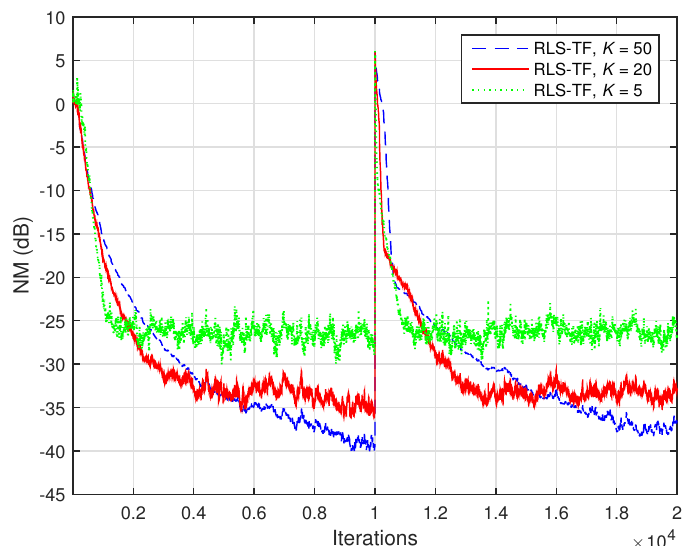
Figure 4. Normalized misalignment (NM) evaluated based on (58), in dB, for the identification of the global impulse response h (of length L = 2048) from Figure 2d, using the RLS-TF algorithm with different values of the forgetting factors λ i = 1 − 1/ ( KL i ) , i = 1,2,3 (varying the value of K